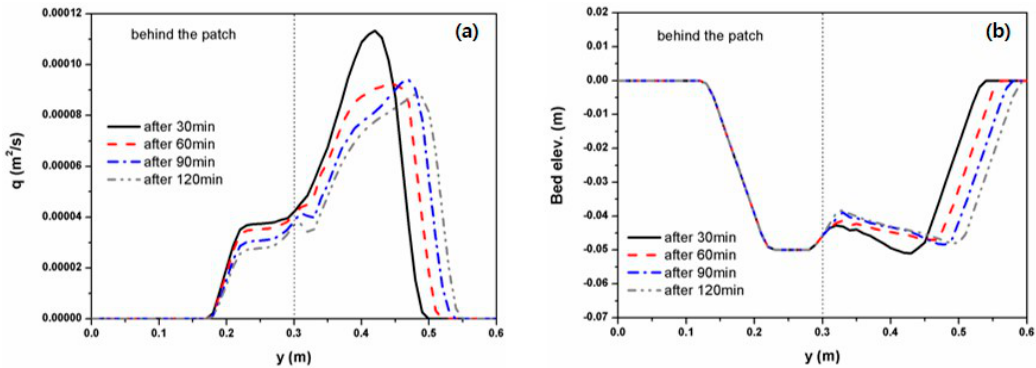
Figure 11. Computational results of ( a ) lateral unit discharge and ( b ) bed profile with different time at y = 4.3 m for the high density of case 2.